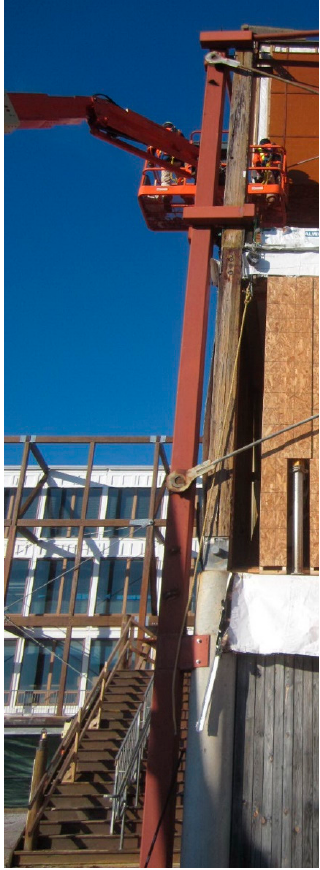
Figure 5. Engineered wood structural members expressed on the exterior envelope of the building. Photo: Wiss Janney Elstner, Inc.